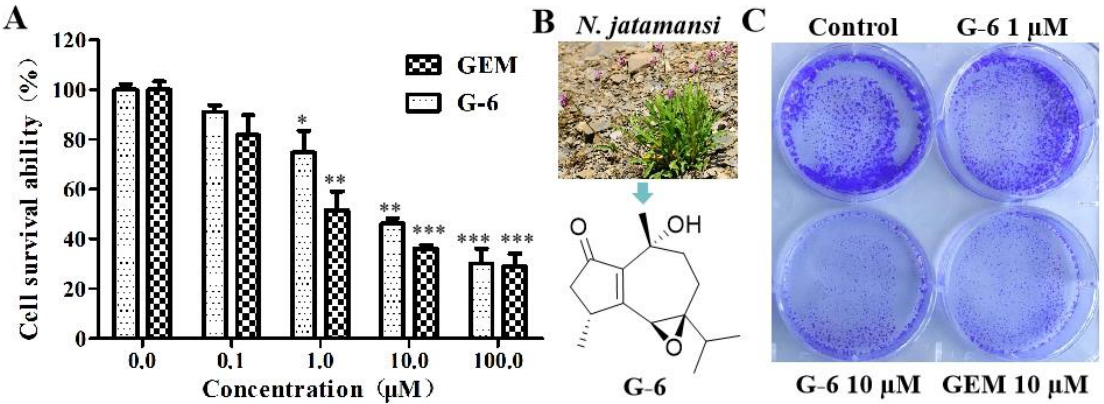
Figure 1. G-6 inhibited SW1990 cells proliferation and colony formation. ( A ) The effect of G-6 inhib- iting SW1990 cells proliferation. SW1990 cells were treated with various concentrations of G-6 for 72 h, respectively, with GEM as positive control. Data shown are means ± SEM ( n = 3). * p < 0.05, ** p < 0.01, *** p < 0.001 vs. 0 µM. ( B ) The structure of G-6 isolated from N. jatamansi. ( C ) The effect of G-6 inhibiting SW1990 cells colony formation. SW1990 cells were treated with 1 and 10 µM of G-6 for 24 h, and stained with crystal violet, with GEM 10 µM as positive control.